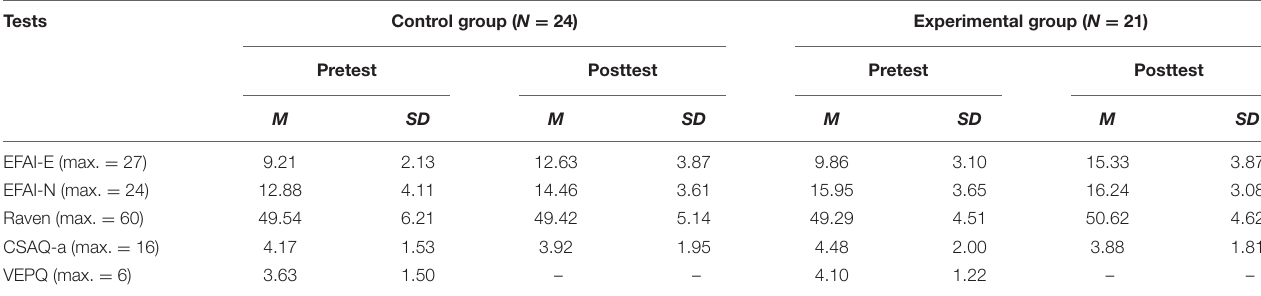
TABLE 1 | Mean scores and standard deviations of the two groups (control and experimental group) for the different tests used in both phases of the study. Tests Control group ( N = 24) Experimental group ( N = 21) Pretest Posttest Pretest